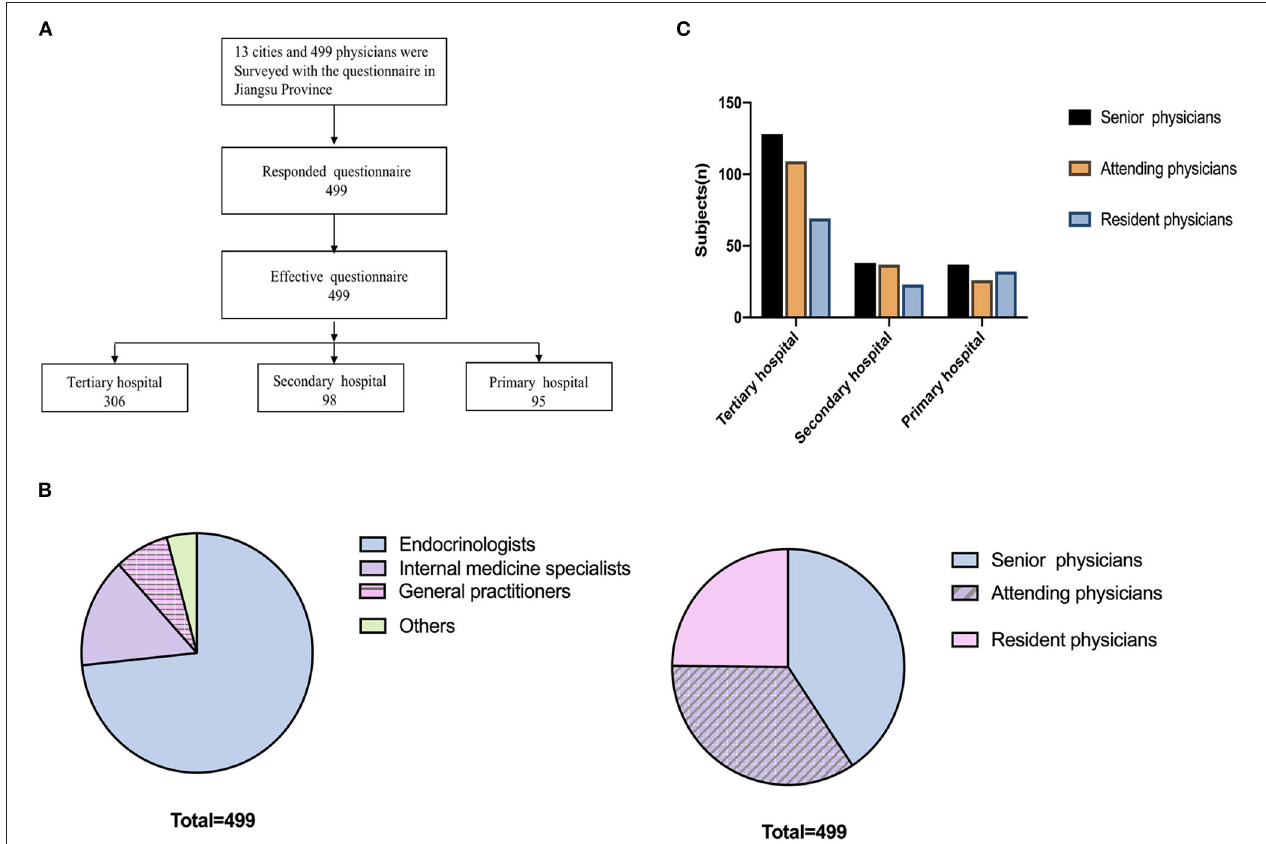
FIGURE 1 | Survey administration. (A) 499 physicians in 13 cities of Jiangsu province completed the survey. (B) Comparison of the participating physicians. (C) Physician seniority